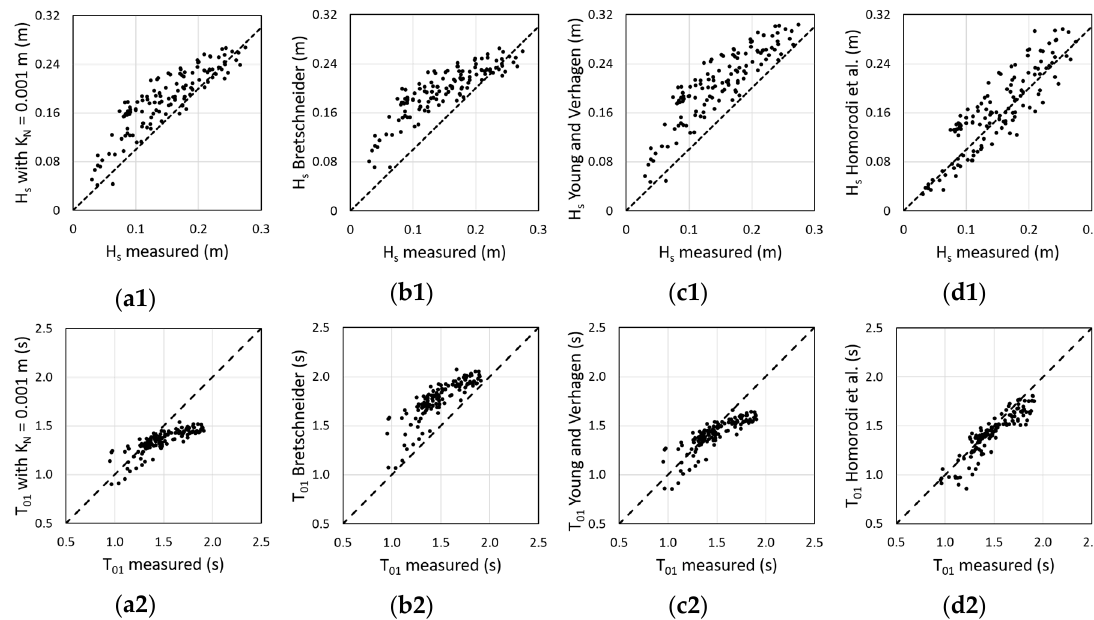
Figure 11. Correlation between the fully developed wave data measured in October 2005 and that given by: ( a1-2 ) the growth curve with K N = 0.001 m; ( b1-2 ) Bretschneider [58] formulation; ( c1-2 ) Young and Verhagen [26] formulation; ( d1-2 ) Homorodi et al. [53] bidimensional (2D) spectral application.